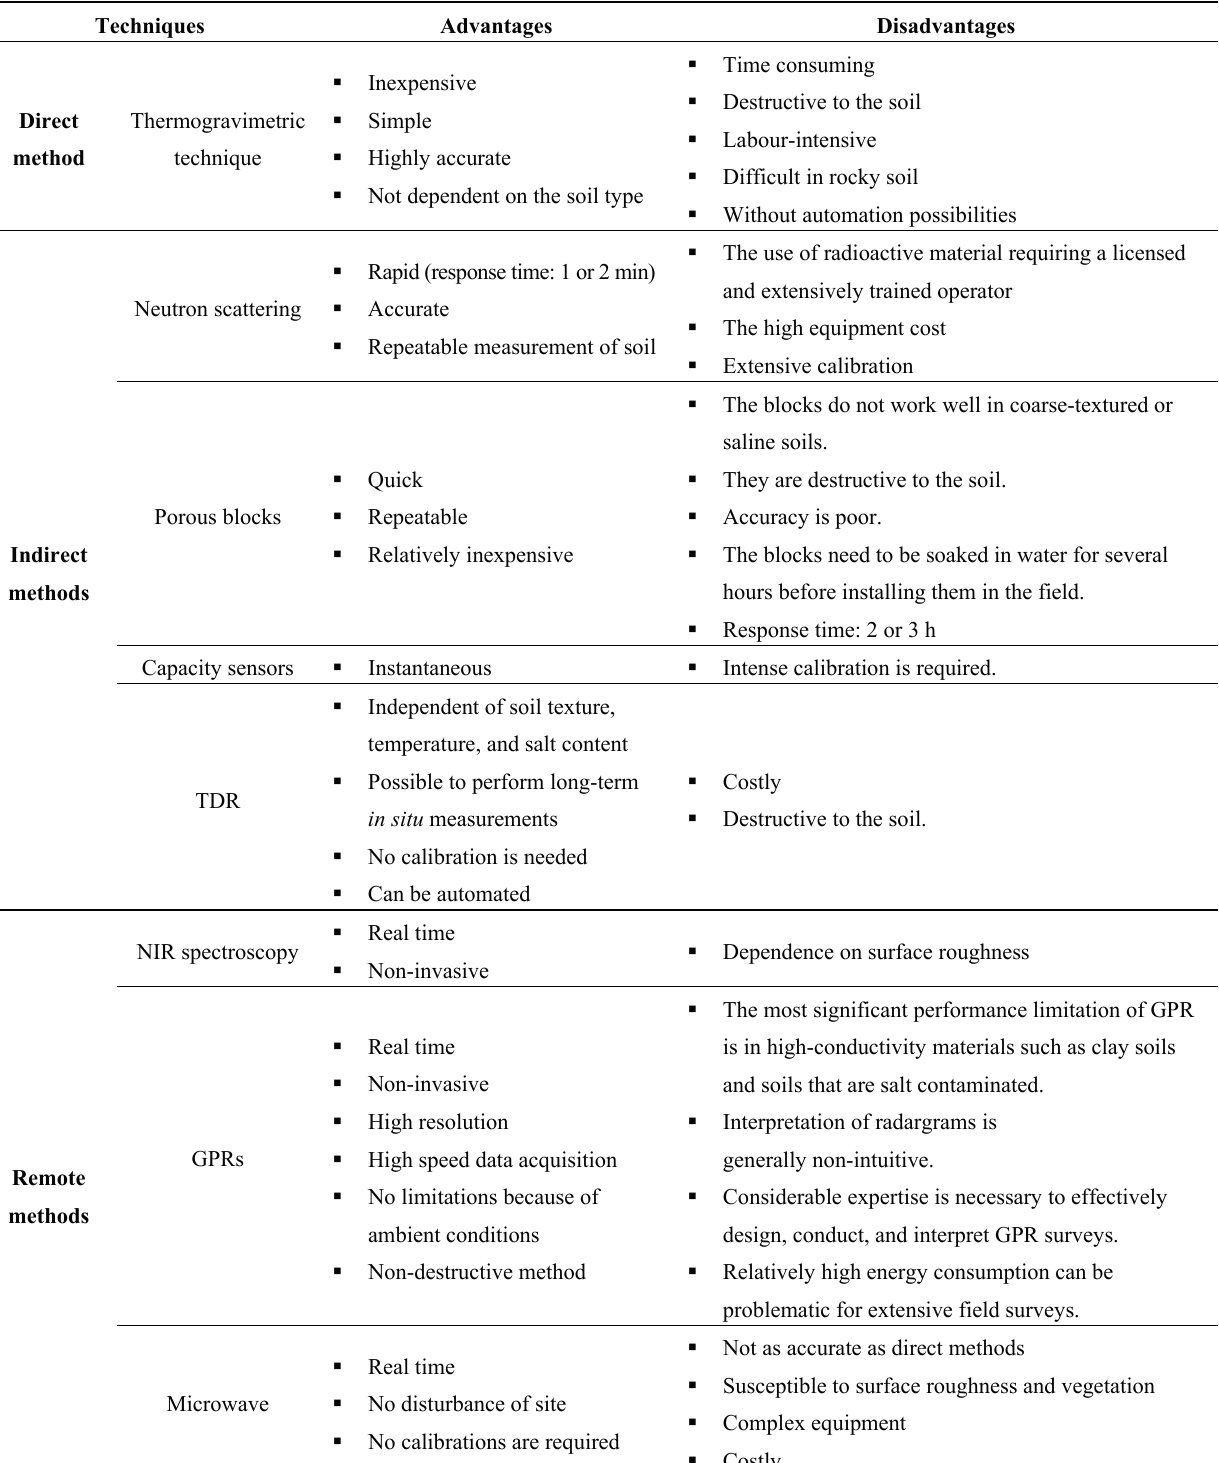
Table 1. Main advantages and disadvantages of methods for estimating soil water